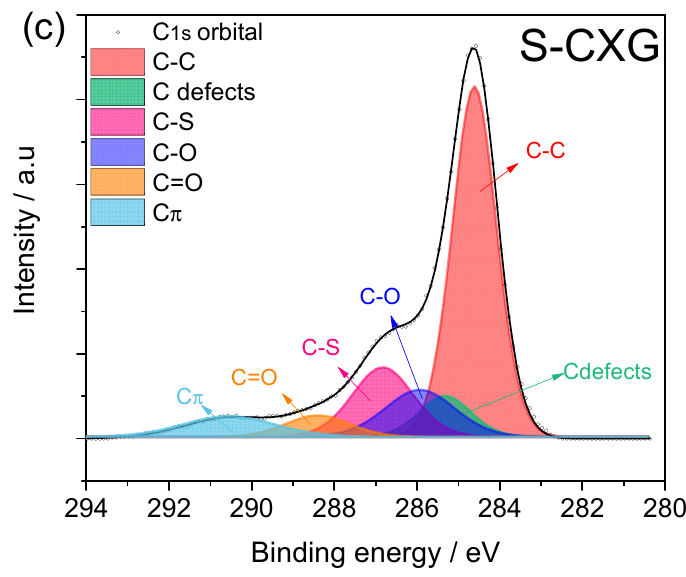
Figure 3. XPS spectra in the C1s region for ( a ) CXG, ( b ) N-CXG and ( c ) S-CXG.